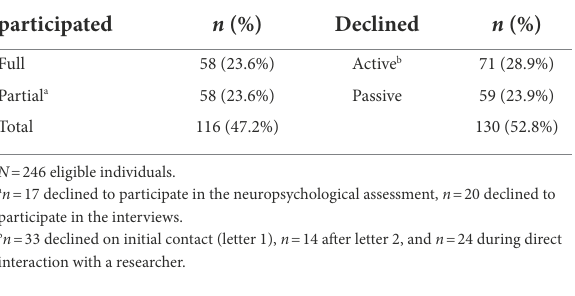
TABLE 1 Participation rate and type of